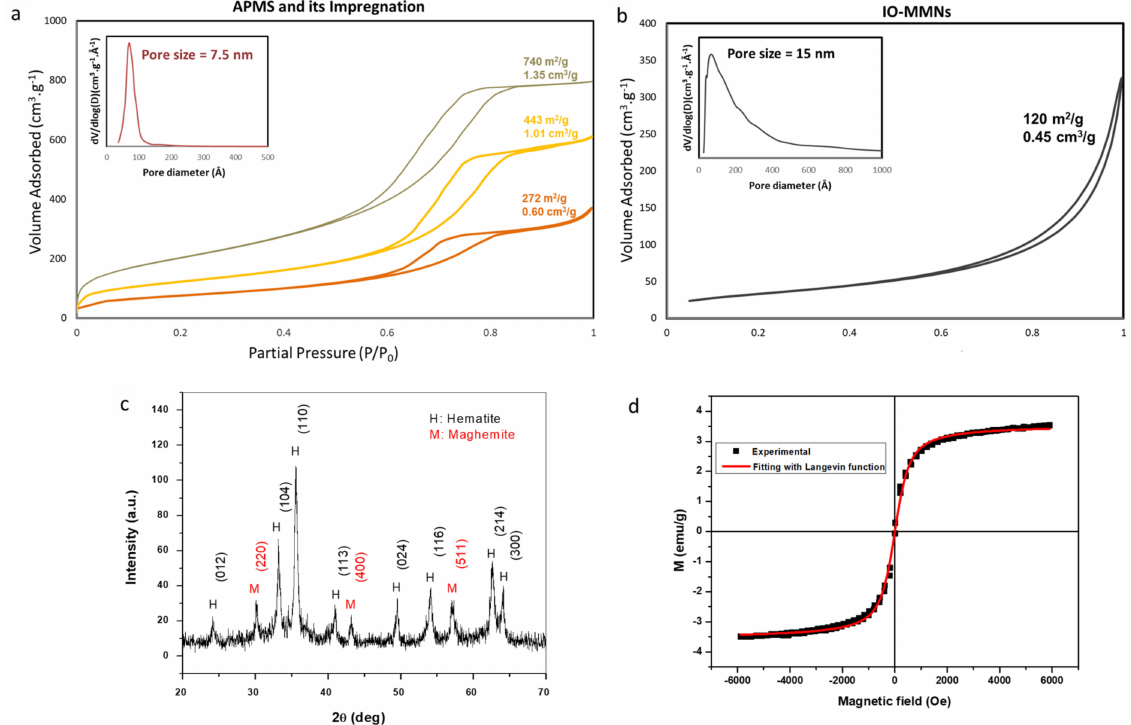
Figure 3. Nitrogen physisorption isotherms for ( a ) APMS and its sequential loading with iron; ( b ) final IO-MMNs after etching and removal of the silica template (inset: Corresponding pore size distribution plots). ( c ) Wide-angle XRD pattern of IO-MMN. ( d ) Field-dependent magnetization hysteresis loops of IO-MMN at room temperature fitted with Langevin function. The results depict the successful formation of IO-MMNs with high surface area and controllable pore volumes, excellent crystallinity, and superparamagnetic